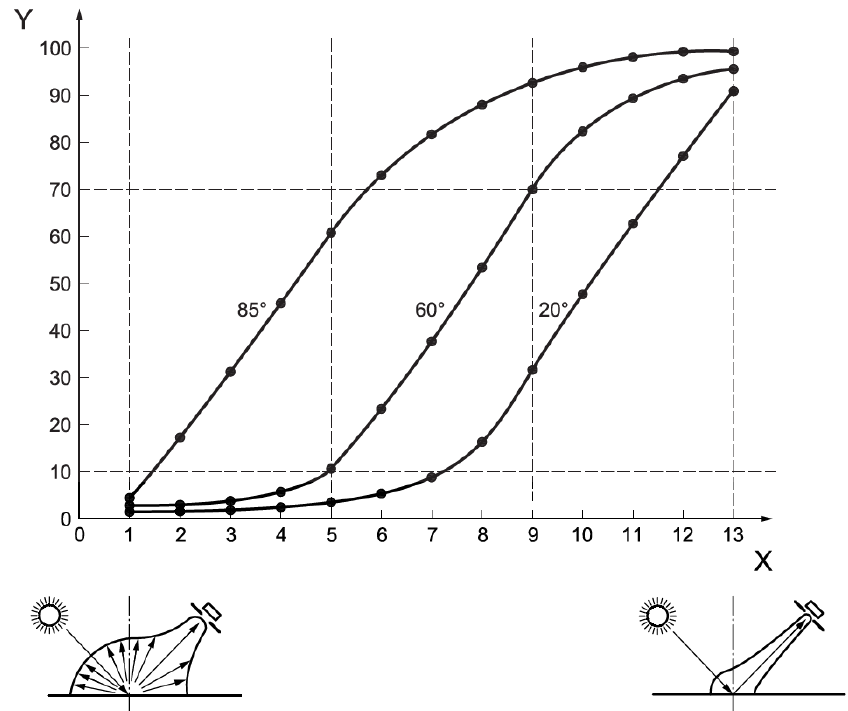
Figure 3. Incident angle for gloss measurement. Y-axis represents the gloss value. X-axis represents gloss perception, from matt to glossy. Image taken from [15].